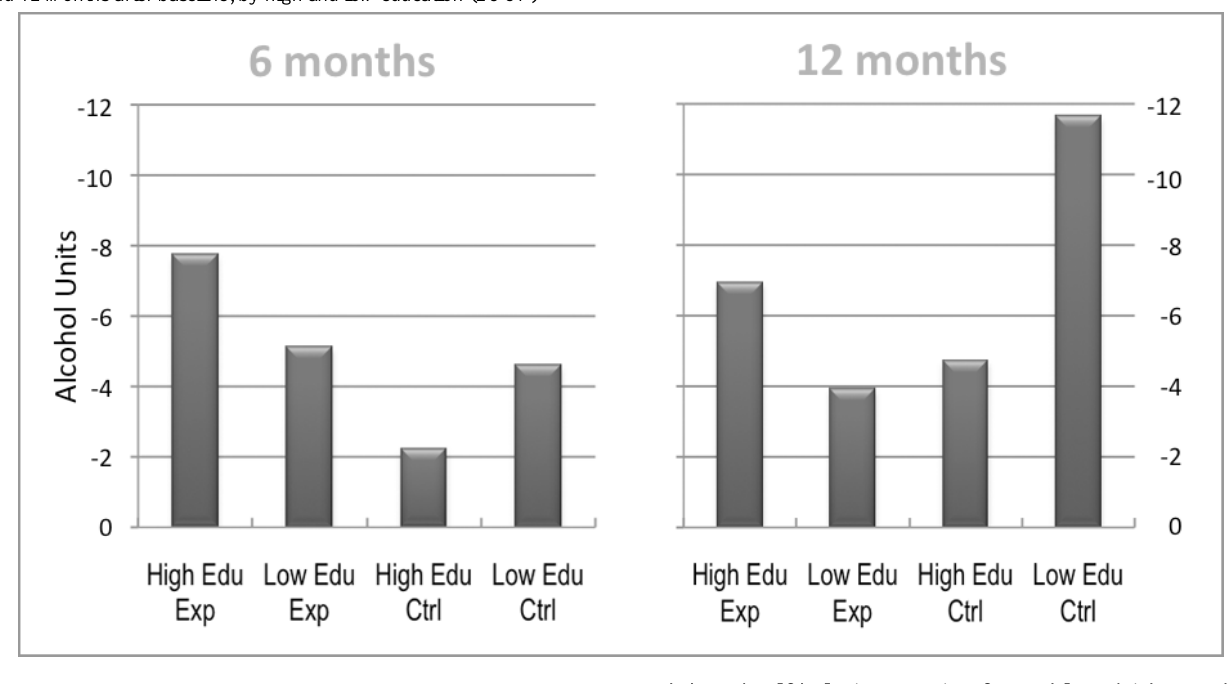
Figure 4. Reductions in mean weekly alcohol consumption (in mean weekly units containing 10 g of ethanol) in experimental and control groups 6 and 12 months after baseline, by high and low education